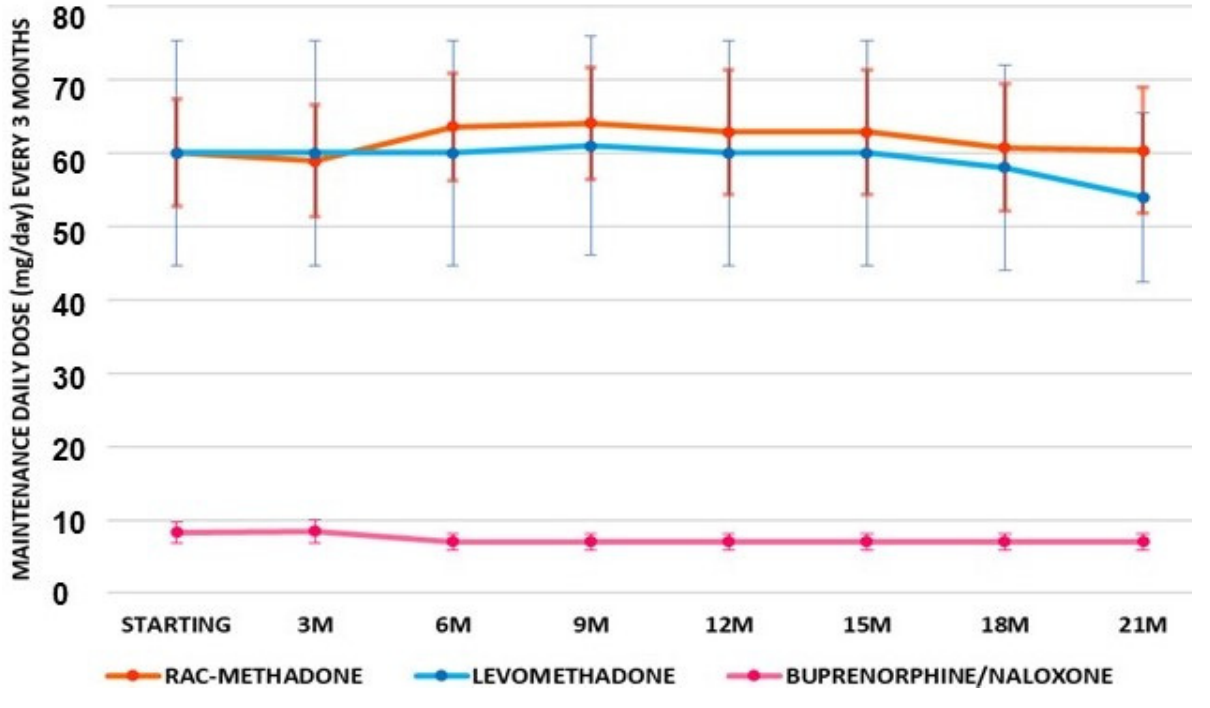
Figure 3. Maintenance means doses of patients under treatments (number of patients = 30) with rac-methadone, levomethadone, and buprenorphine-naloxone, at 90 days of intervals for 21 months (21M) of treatment.